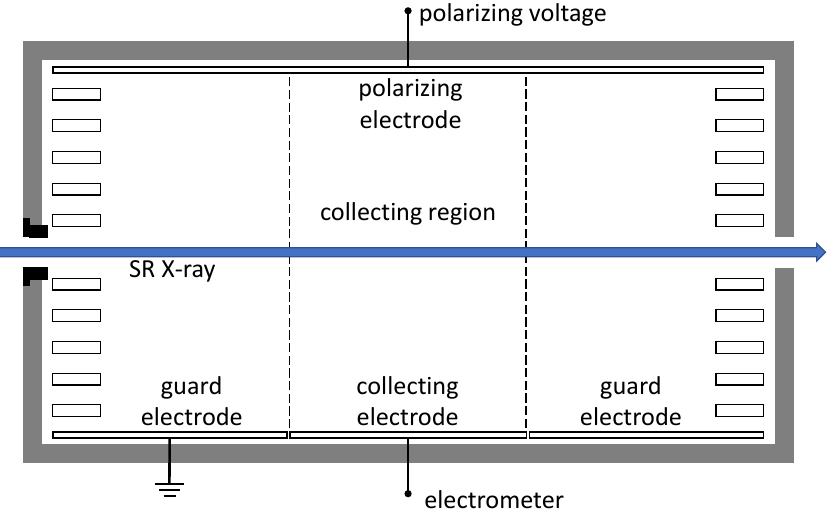
Figure 1. Simplified schematic diagram of a free-air ionization chamber. Photons enter and interact with the air in the chamber to produce electron-ion pairs. Charge in the collecting region is collected and measured as an ionization